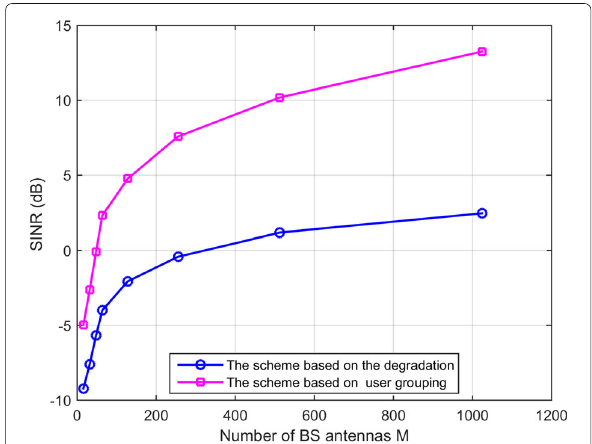
Fig. 7 The impact of grouping parameter on the target cell’s achievable sum